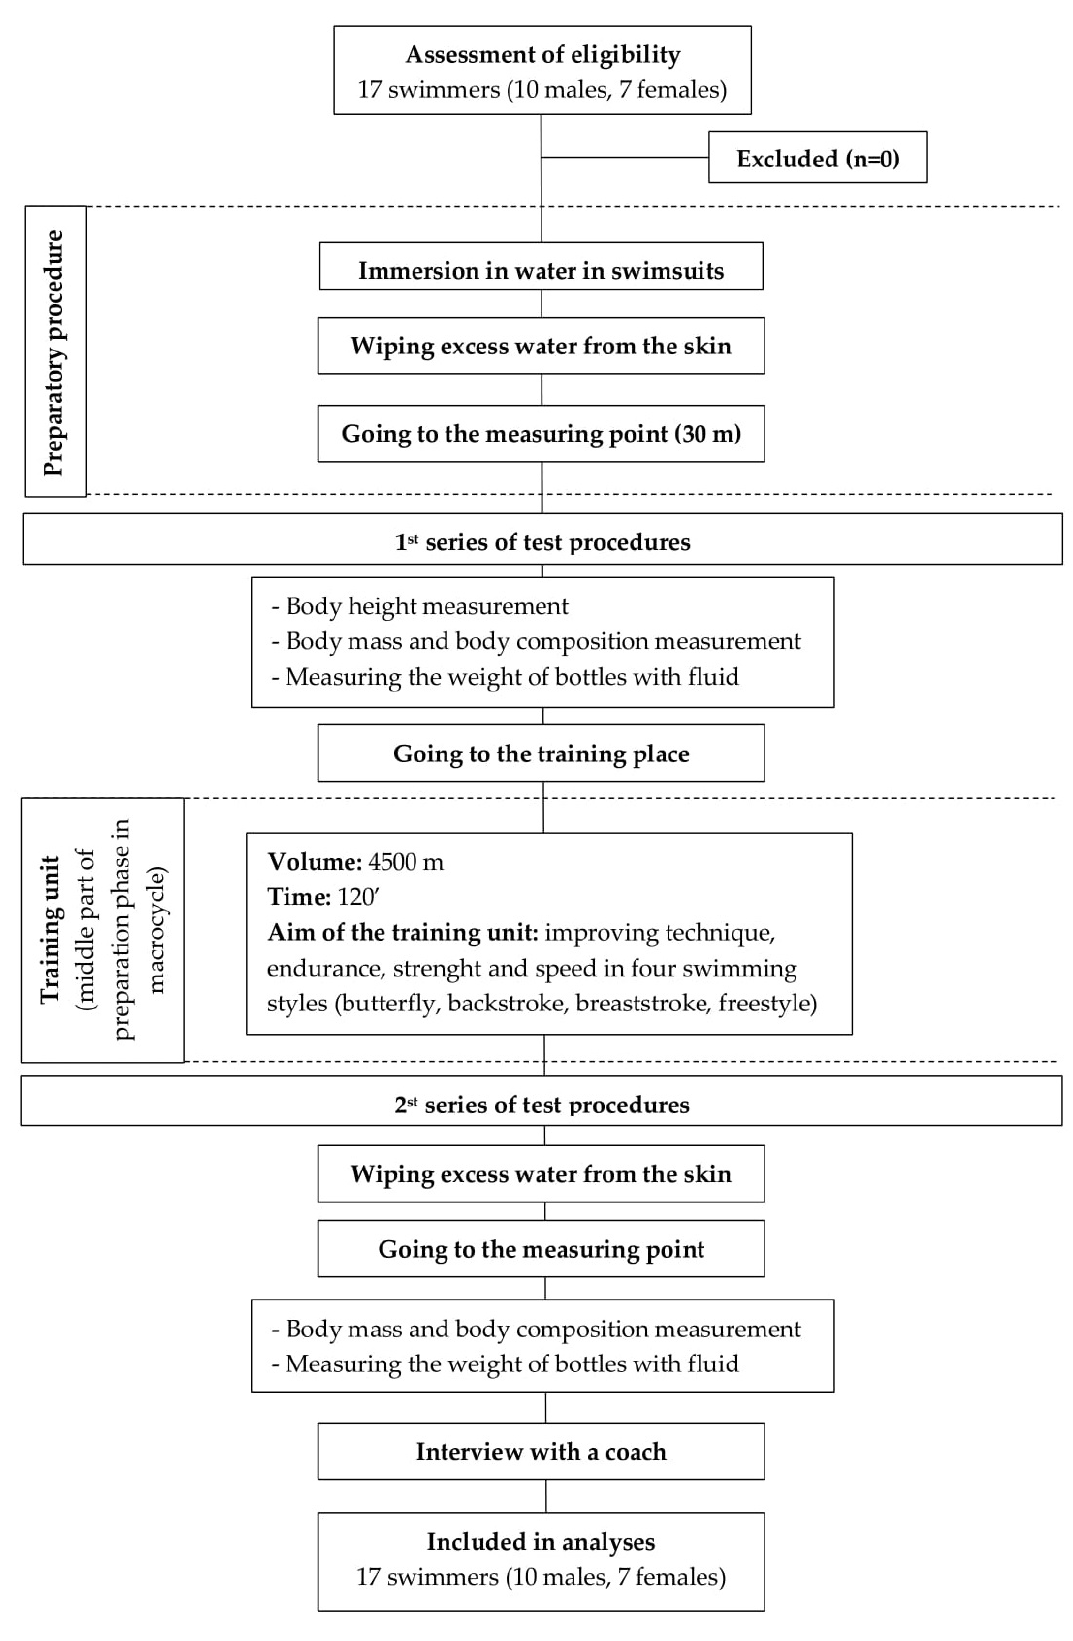
Figure 1. A flow chart of the study design.